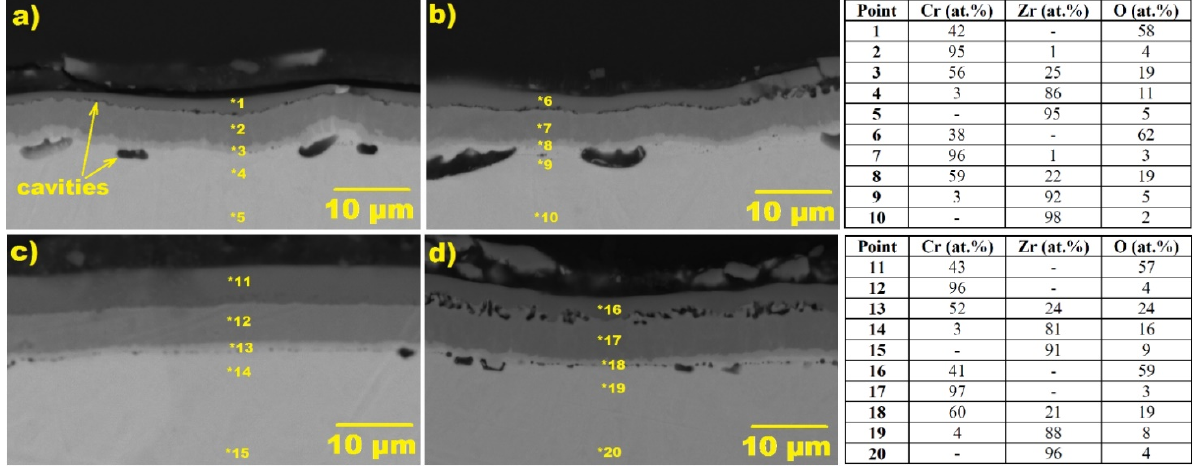
Figure 8. Cross-section SEM microstructure of the ZrO 2 /Cr-100 ( a , b ) and ZrO 2 /Cr ( c , d ) samples after steam oxidation at 1200 °C for 1000 and 2000 s, respectively.